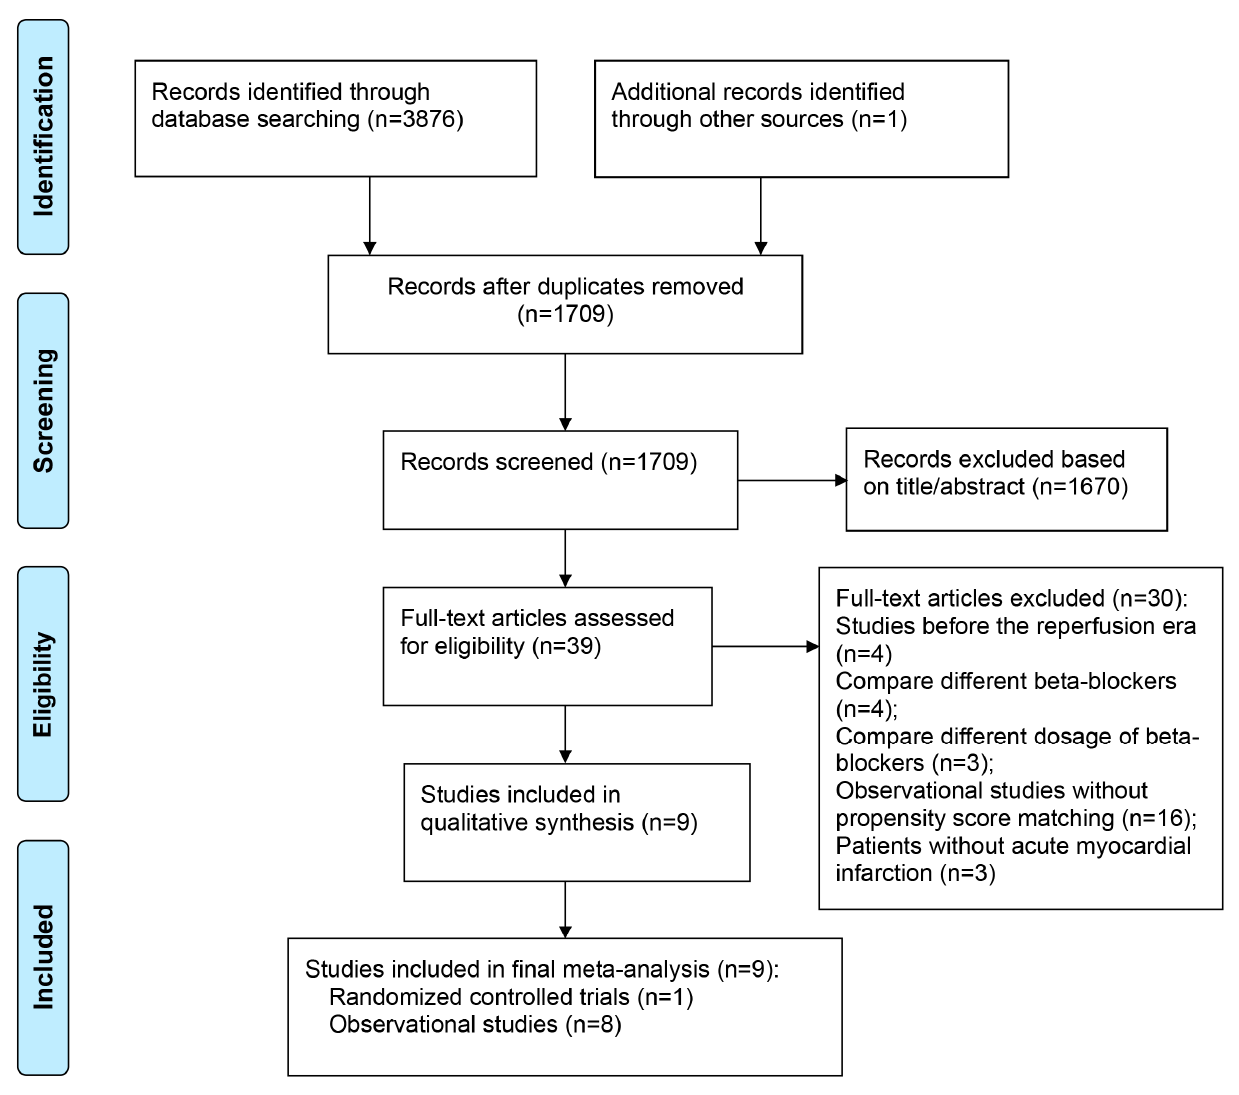
Figure 1. PRISMA Diagram for Study Inclusion.